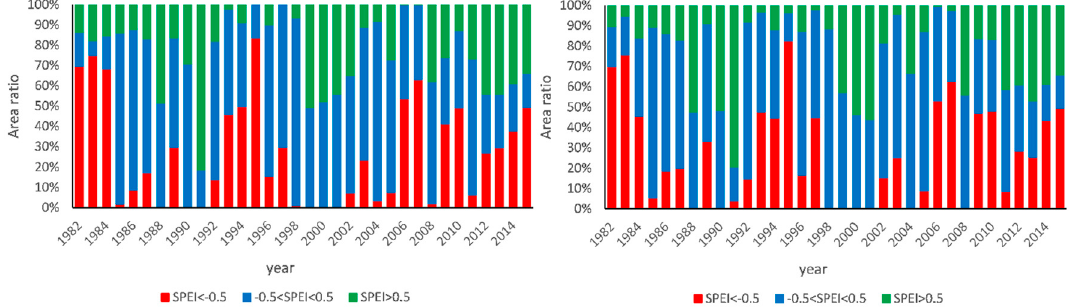
Figure 6. Area proportions of the dry, wet, and normal areas indicated by the annual (left ) and growing season ( right ) SPEI in different ranges.